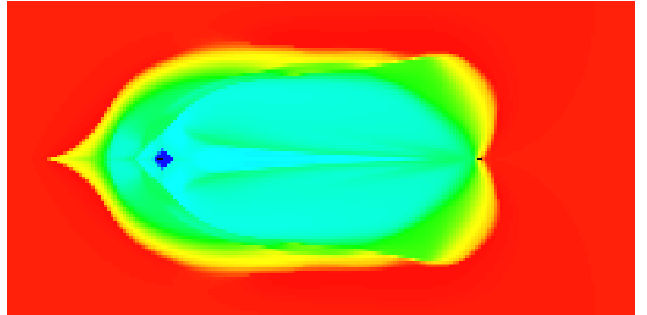
Figure 7. Distribution of formation oil saturation at 400 days of production.